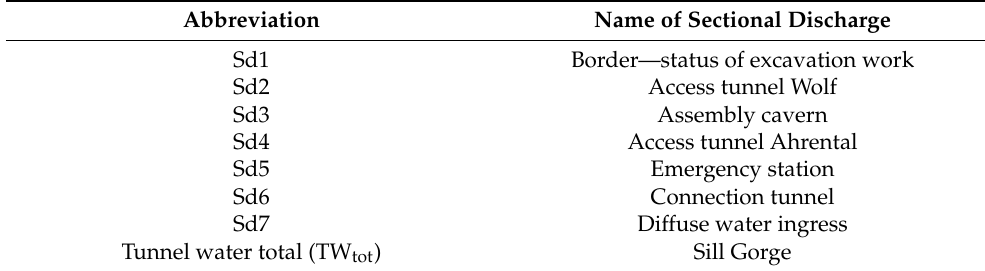
Table 1. Overview of the sectional